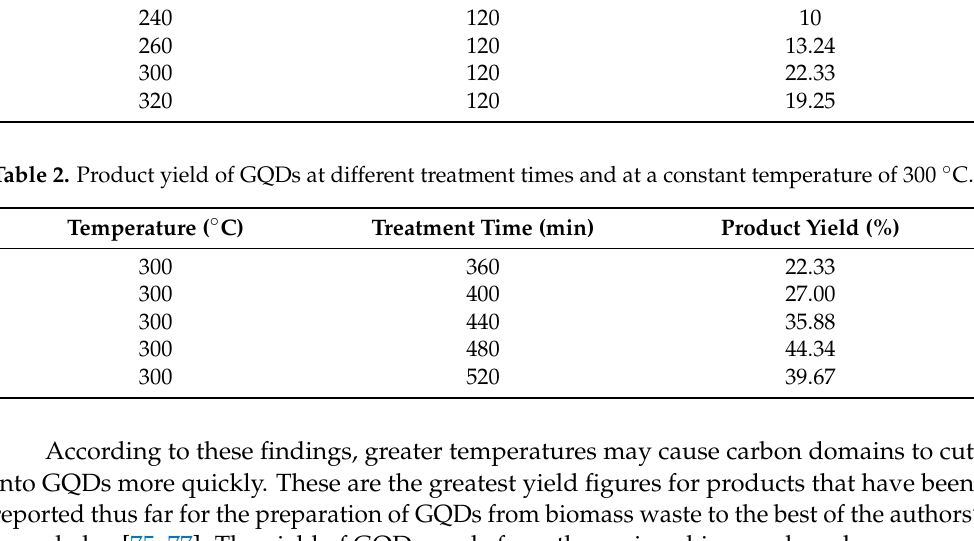
Table 1. Product yield of GQDs at different reaction temperatures and constant heat treatment time.